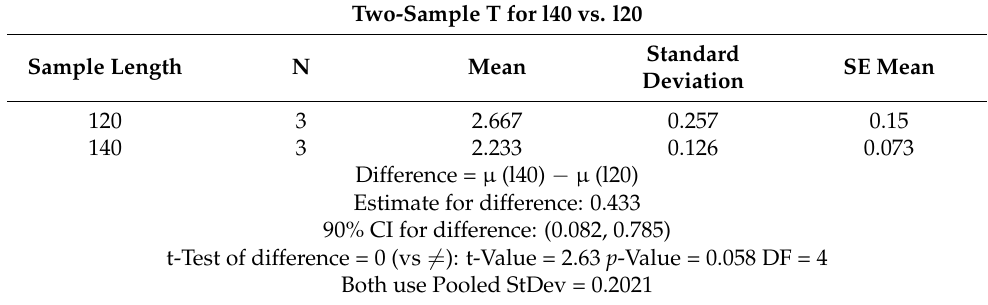
Table 4. Minitab results for the t-test.